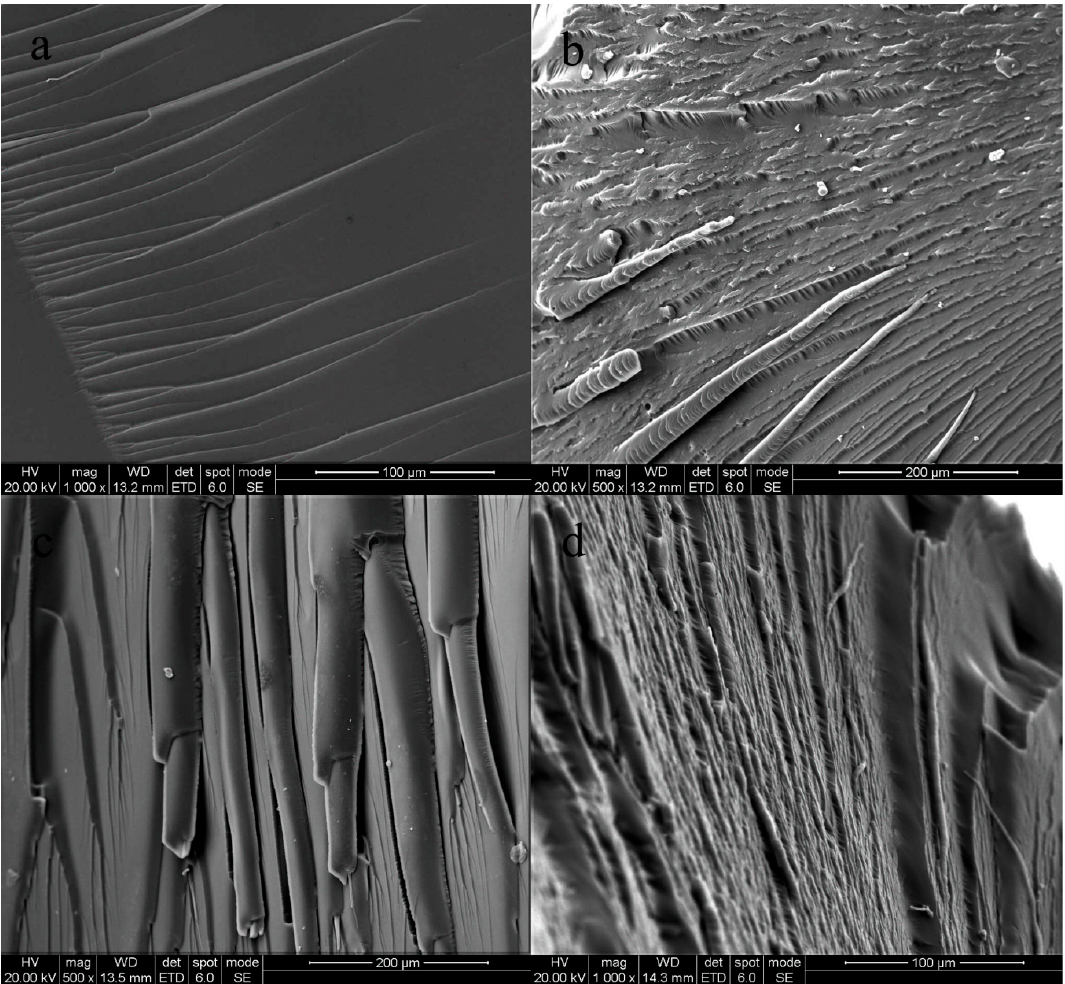
Figure 4. Scanning electron microscopy (SEM) images of the fracture surfaces of cured neat EP ( a ), 10% EP-PUP ( b ), 20% EP-PUP ( c ), and 30% EP-PUP ( d ).